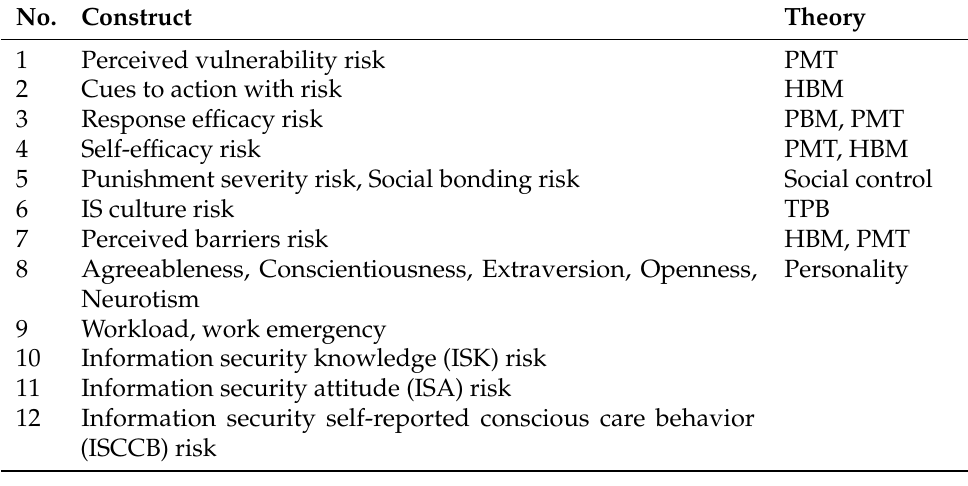
Table 1. Study constructs and their theoretical origin.